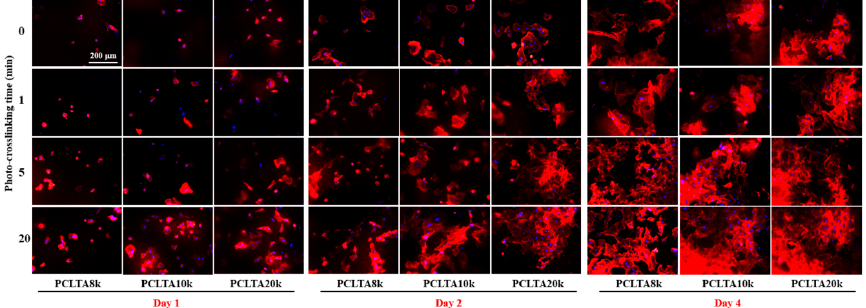
Figure 6. SMC images at days 1, 2, and 4 post-seeding stained using rhodamine-phalloidin (RP; red) and 4 ′ ,6-diamidino-2-phenylindole (DAPI; blue) on PCLTAs with different crosslinking time. Scale bar of 200 μ m is applicable to all.